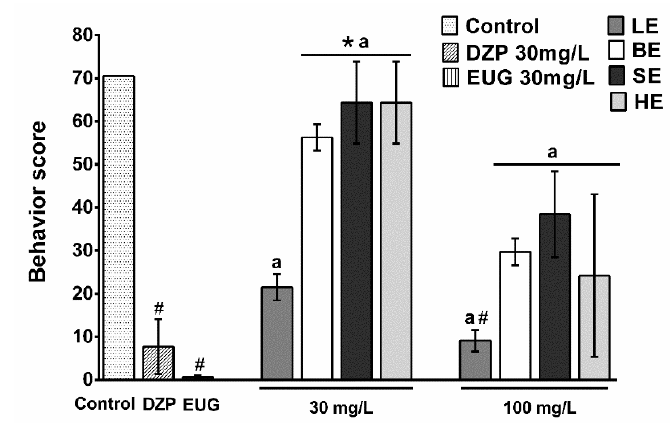
Figure 2. Fish 24 h-behavior under sedative bath with 30 or 100 mg/L M. tinctoria extracts. Behavior score was adapted from Heldwein et al. Different lowercase letters indicate significant difference between extracts. Leaves (LE), bark (BE), sapwood (SE), and heartwood extracts (HE), Diazepam (DZP) at the evaluated concentrations ( p < 0.05). The abscissa shows the concentrations of the tested samples (in mg/L), while the ordinate represents the behavior score. * p < 0.05 = statistical difference from diazepam (DZP); # p < 0.05 = statistical difference from control (Kruskal–Wallis test followed by Dunn’s test).